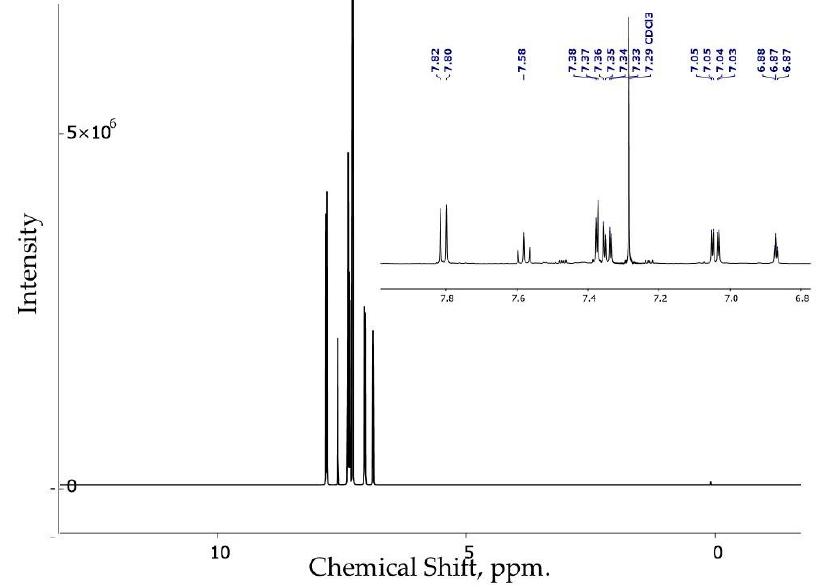
Figure 1. 1 H NMR spectrum of complex 6 in CDCl 3 .